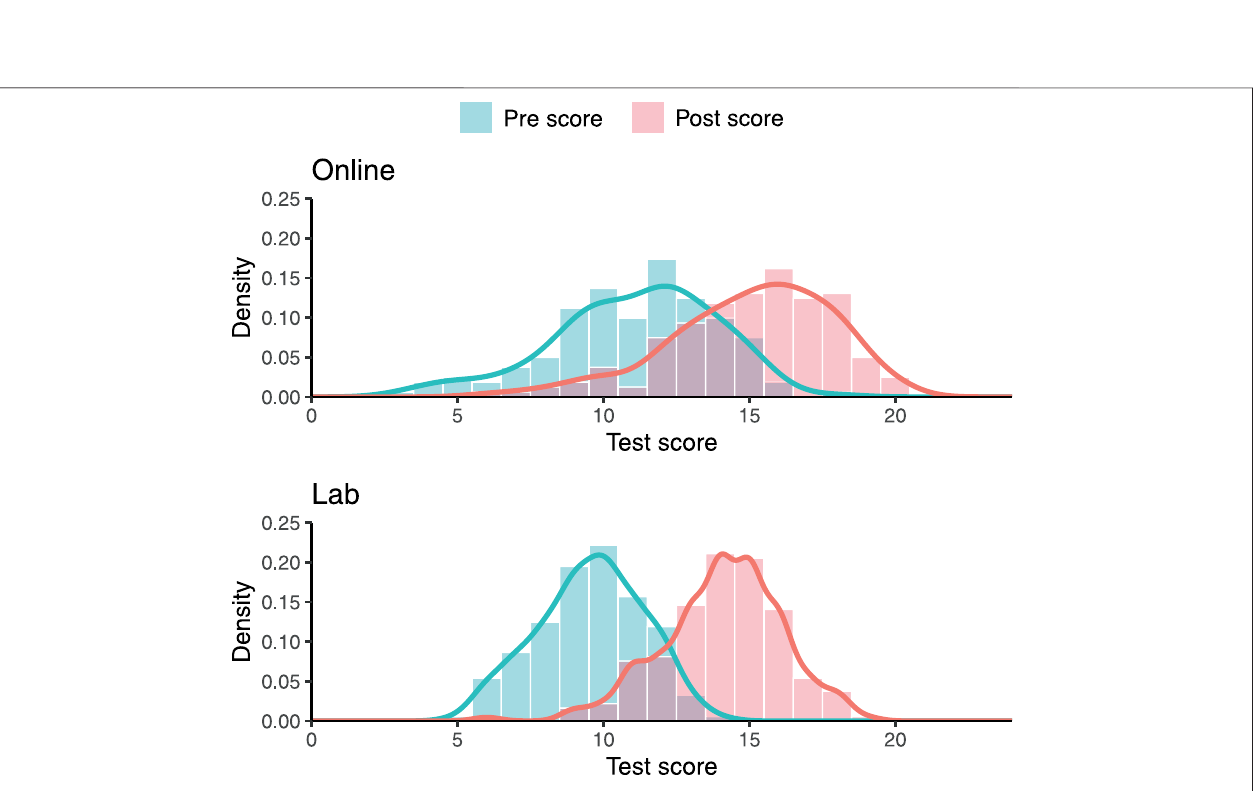
FIGURE 2 | Histograms of correct answers to the MCQ (factual and conceptual scores combined). Online N (cid:1) 161, Lab N (cid:1) 185. Participants in both studies signi fi cantly increased their test scores.